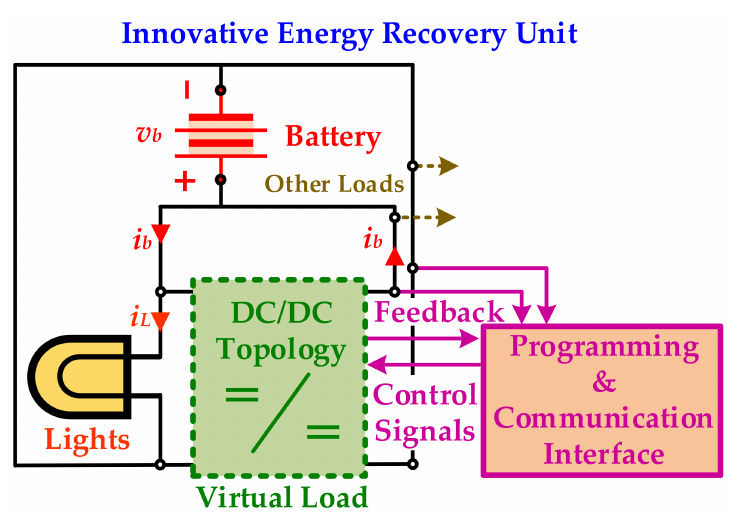
Figure 2. Novel energy recovery unit to be incorporated in heavy-duty vehicles’ LED lighting